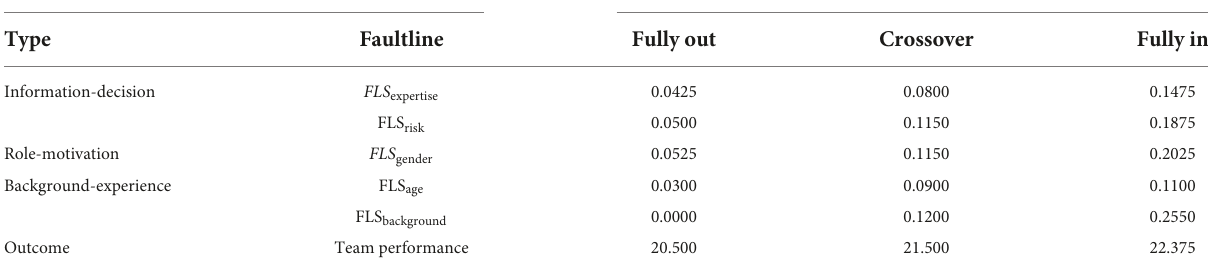
TABLE 5 Necessity test